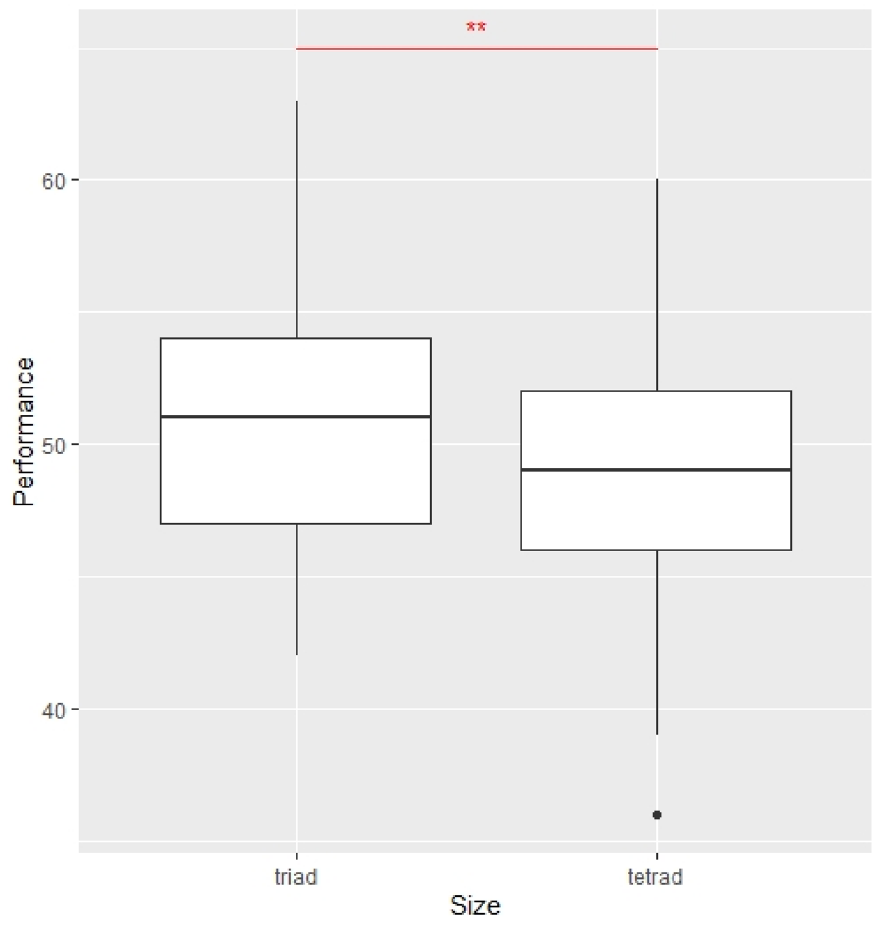
Figure 1. Comparison of average performance of triads and tetrads. Error bars represent standard errors of means. The Kruskal–Wallis test test was applied. **p <